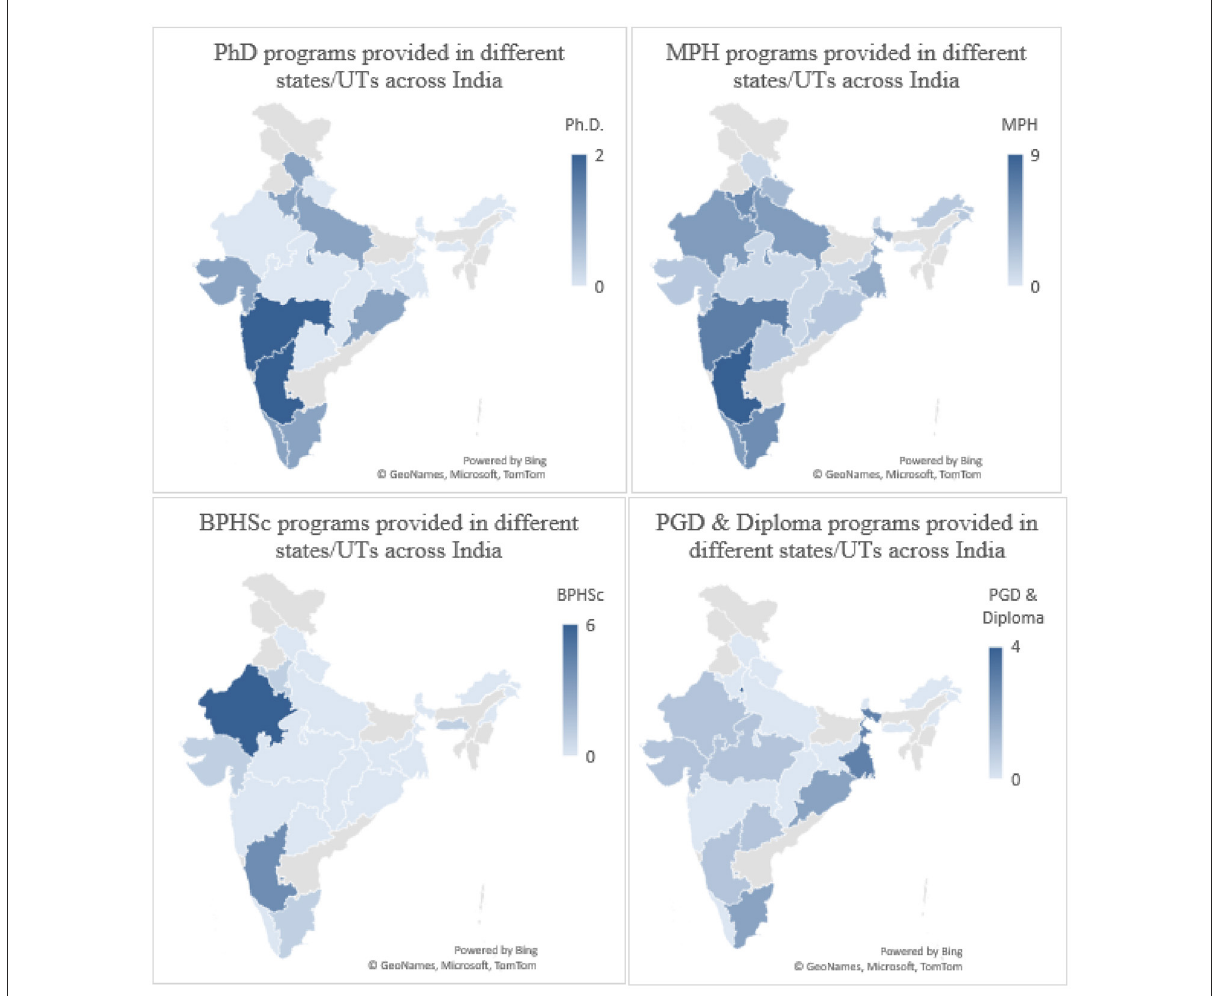
FIGURE5 A comparison of all the different types of public health programs across different States/UTs in